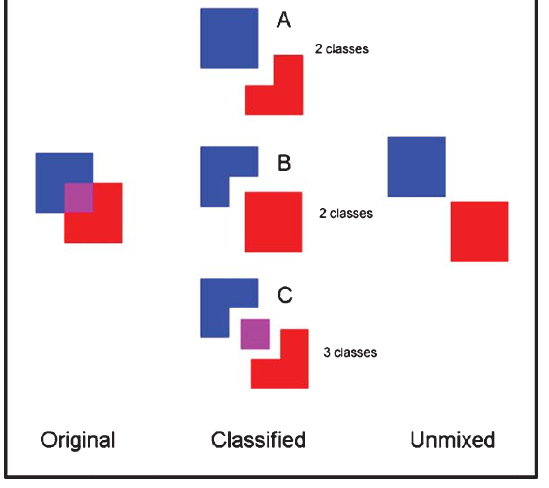
Fig. 6. Classification vs.